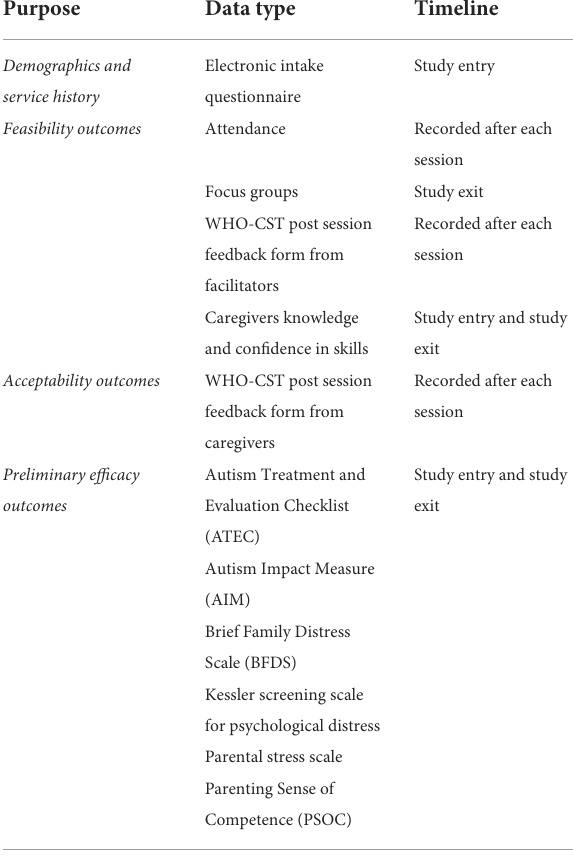
TABLE 2 Description of the instruments and